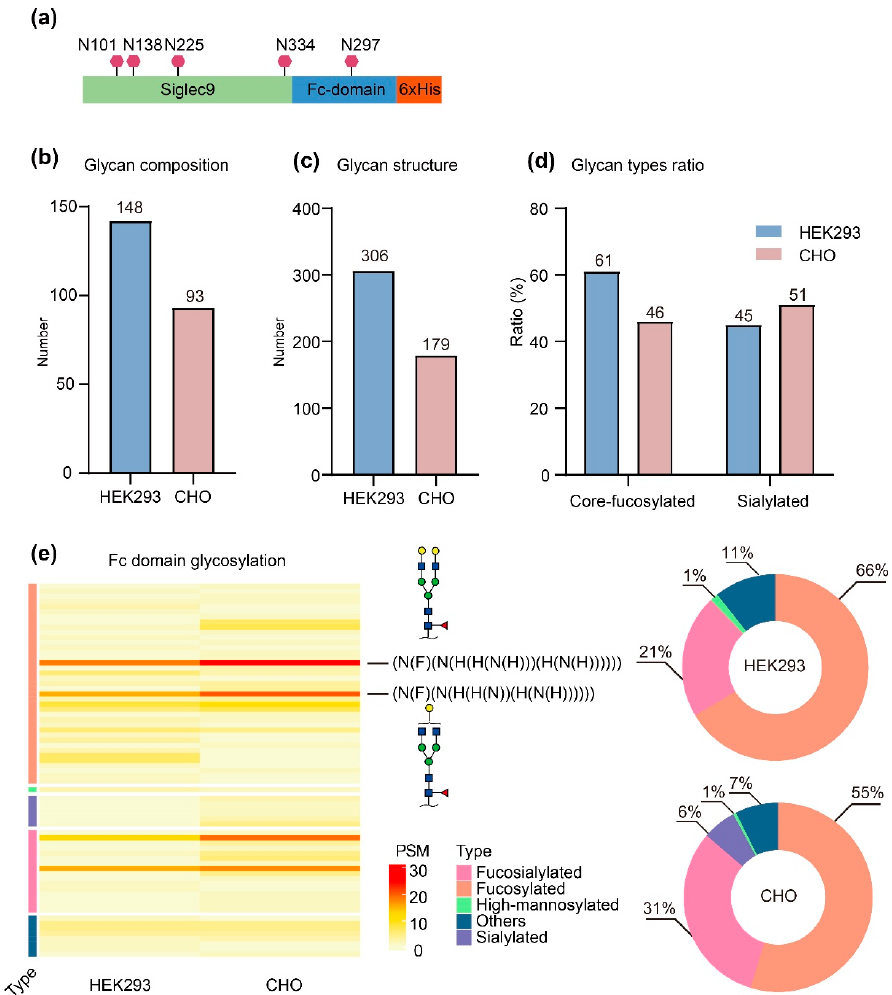
Figure 3. Glycosylation modification of Siglec9-Fc produced in HEK293 and CHO. ( a ) The graph shows five detected glycosylation sites of Siglec9-Fc; the mass results of total glycan compositions ( b ) and potential glycan structures ( c ) detected in HEK293 and CHO; ( d ) the proportion of core- fucosylated or sialylated glycan modification of Siglec9-Fc produced in HEK293 and CHO; ( e ) glycan compositions, distribution and glycan proportion in the Fc domain of Siglec9-Fc protein produced in HEK293 and CHO.